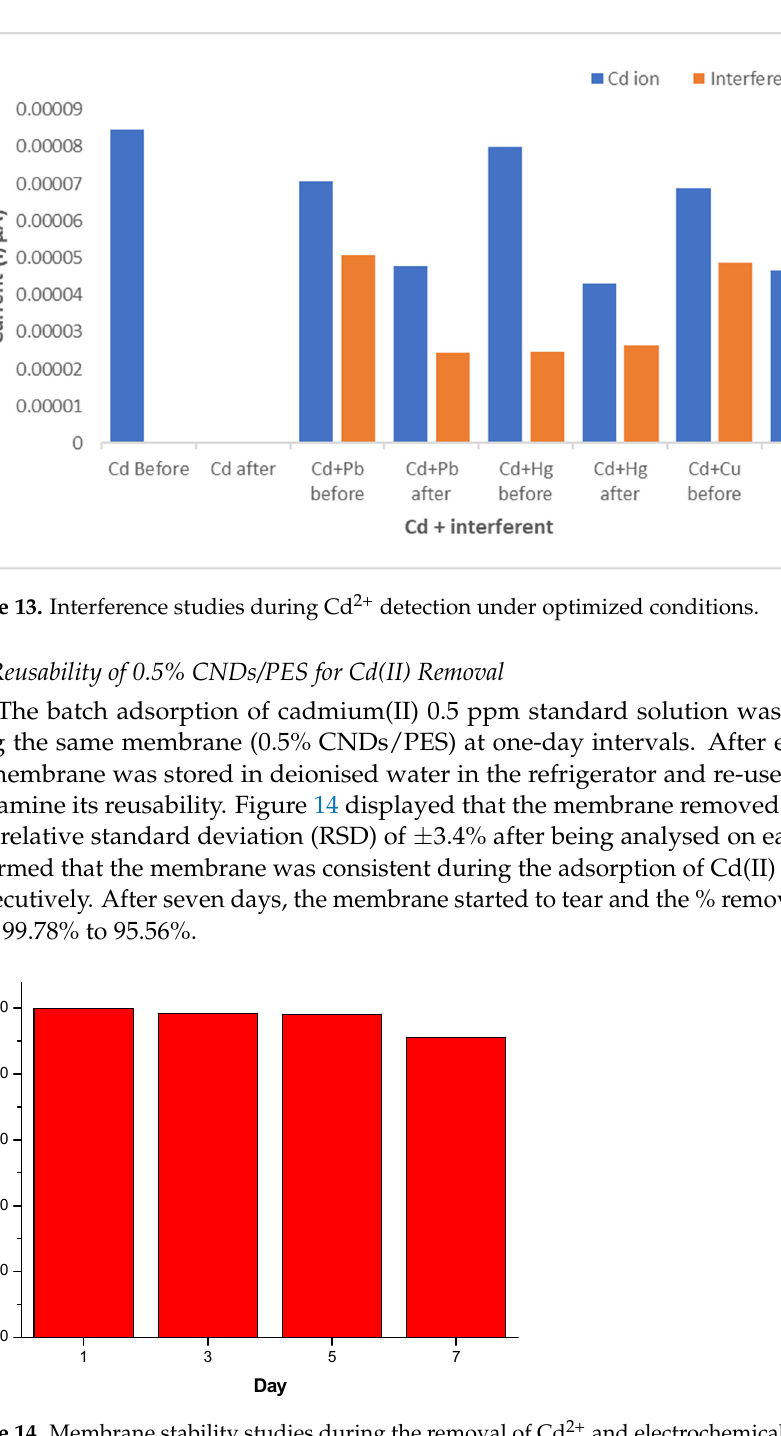
Figure 14. Membrane stability studies during the removal of Cd 2+ and electrochemical sensing using GCE under optimized conditions .